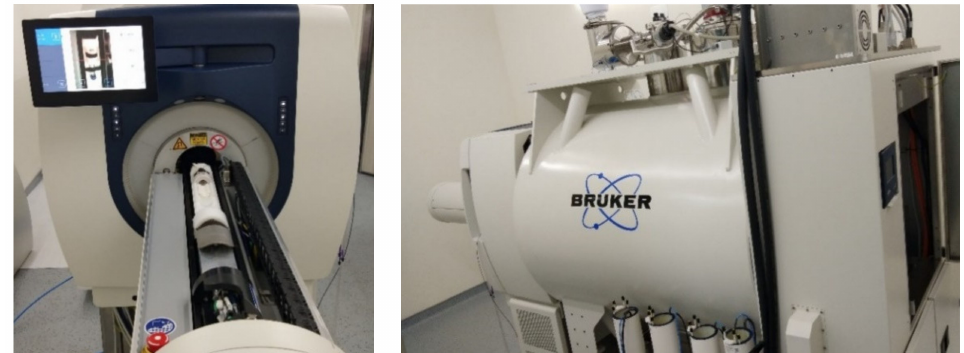
Figure 1. Photographs of Bruker’s small animal 7 Tesla PET/MRI